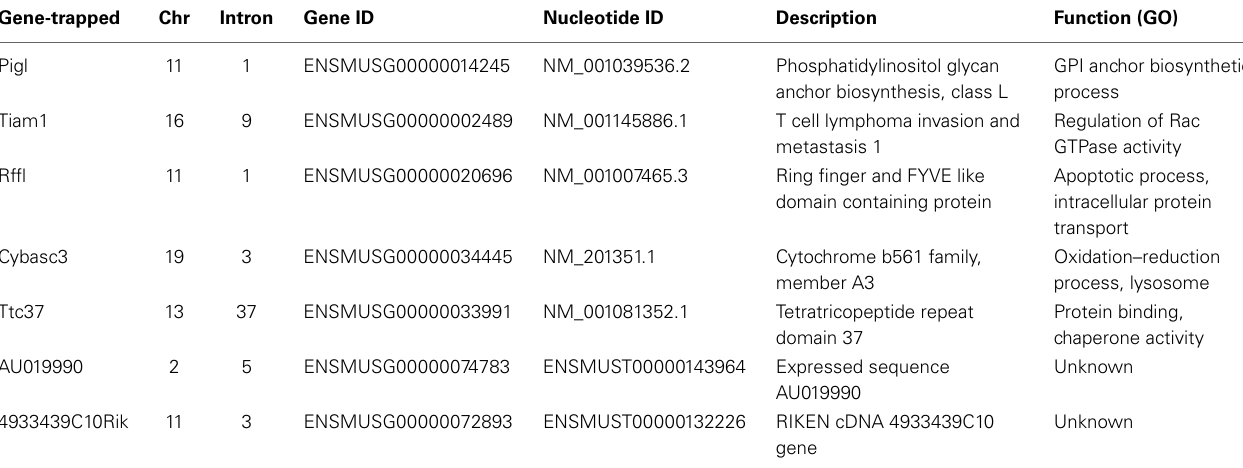
Table 2 | Genes trapped by piggyBac insertion in PQ resistant ES cell clones.